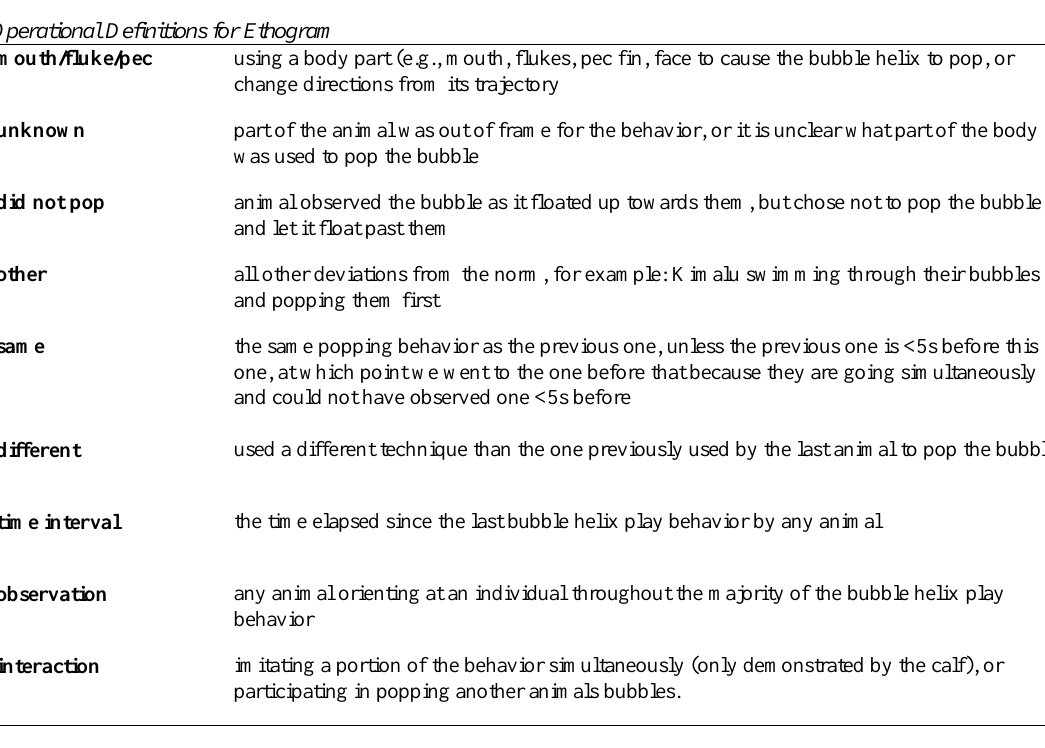
Operational Definitions for